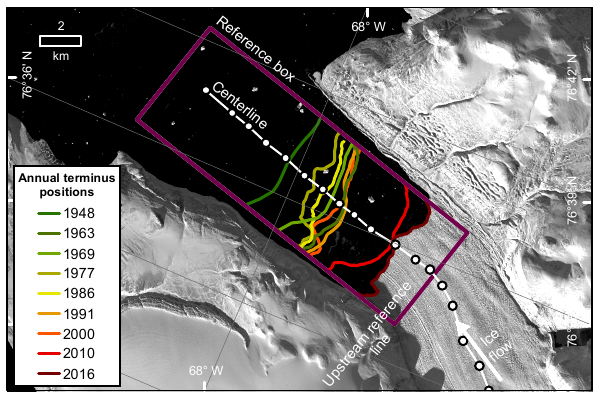
Figure 2. Rectilinear box method used to measure glacier termi- nus positions. An example at Harald Moltke Bræ, NW Greenland. This includes reference box (pink) and roughly decadal terminus positions (green to red). The glacier centre line profile is shown in white, along with the location of 500m sample points (white cir- cles). Background image is Landsat 8 band 8 from the USGS Earth